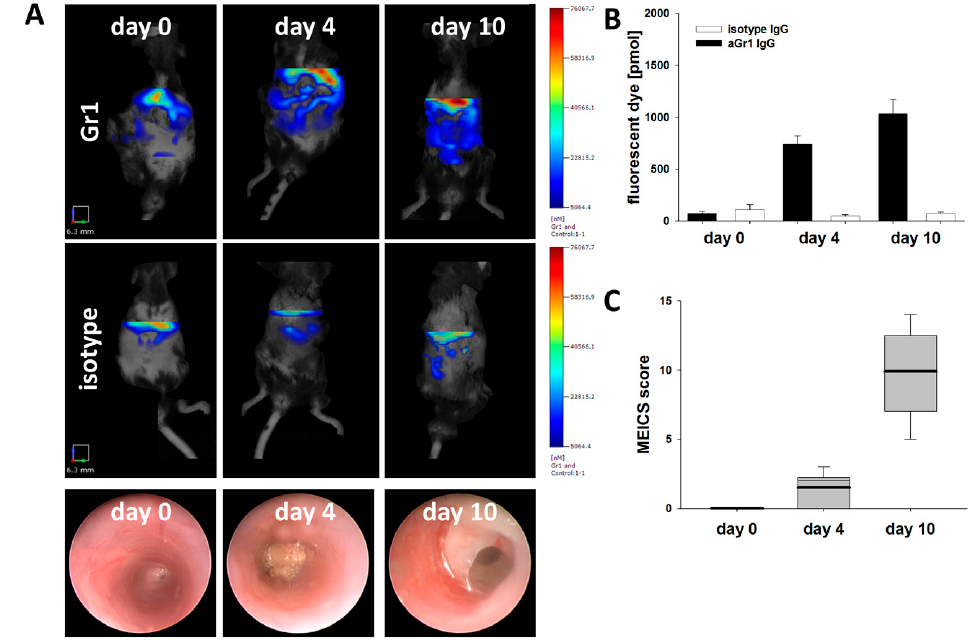
Figure 4. Fluorescence-Mediated Tomography (FMT) visualization of neutrophil infiltrate in murine colitis and correlating white light endoscopy. FMT scans in mice prior (day 0), during (day 4), and after (day 10) induction of colitis. Mice were injected with Cy 5.5 conjugated antibody against murine Gr-1 or equally labeled unspecific control (rat IgG). Prior to each scan, mice were subjected to endoscopy to assess mucosal inflammation of the bowel. Shown are data from one experiment (n = 5 per group) and results were confirmed in two experiments. ( A ) Representative images of FMT scans are shown with color-coded fluorescence intensity corresponding to the extent of inflammatory infiltrate in mice injected with the specific probe (upper panels) and unspecific control (middle panels). In both cases, a region of interest (ROI) of equal size was placed transverse in the upper abdomen for further analysis. Corresponding white ‐ light endoscopic images from the respective colitic mice for each time point acquired prior to FMT scanning are shown in the bottom panels. ( B ) Total fluorescence intensity in pmol dye was determined for all mice in ROI at three time points and depicted ± SEM. FMT ‐ data were analyzed using ANOVA followed by Student–Neuman–Keul (S.N.K.) post hoc test. ( C ) Endoscopic mucosal damage as assessed by murine endoscopic index of colitis severity (MEICS) score was determined prior to each FMT scan and depicted ± SEM. Statistical significance was calculated by Mann–Whitney U test.